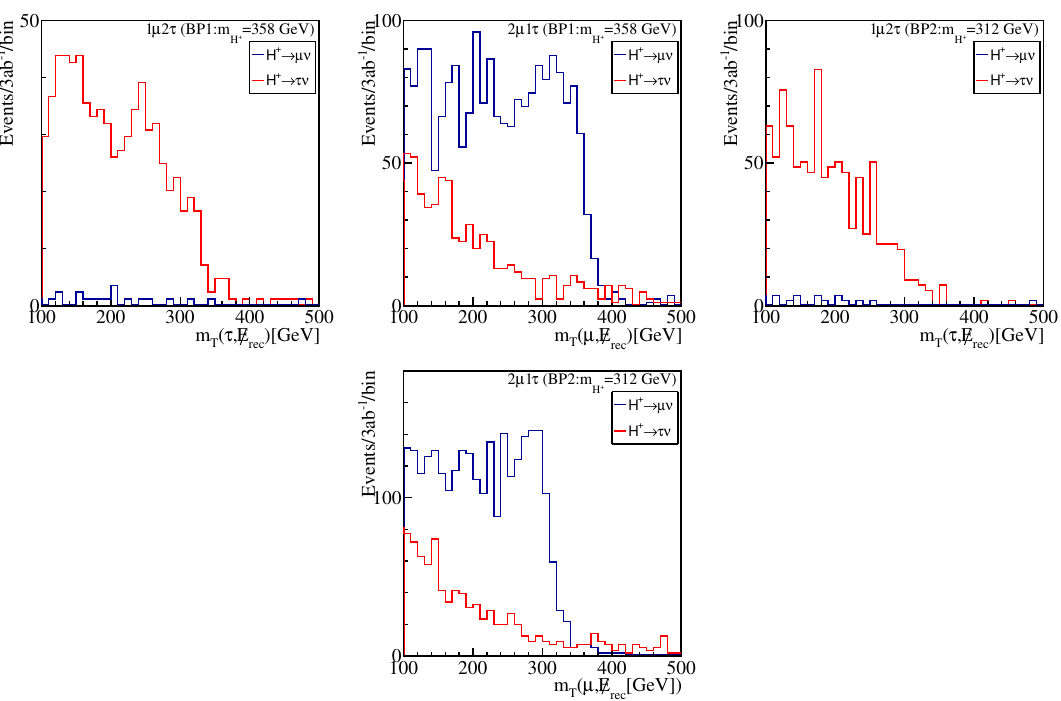
Figure 6 . The m min distribution for 1 (cid:22) 2 (cid:28) mode (left panels) and the m min T;(cid:28) mode (right panels). The upper (lower) panels are for BP1